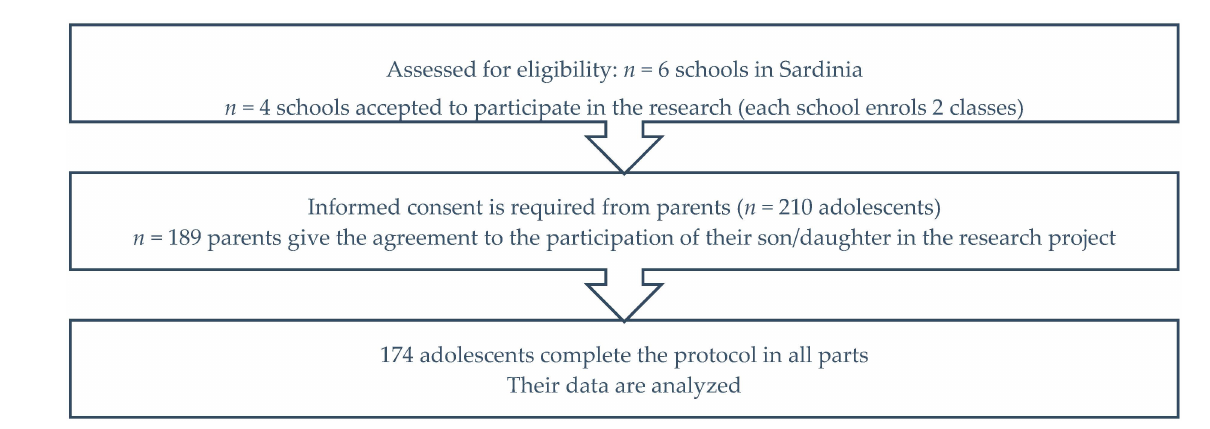
Figure 1. Flow of participants through each stage of